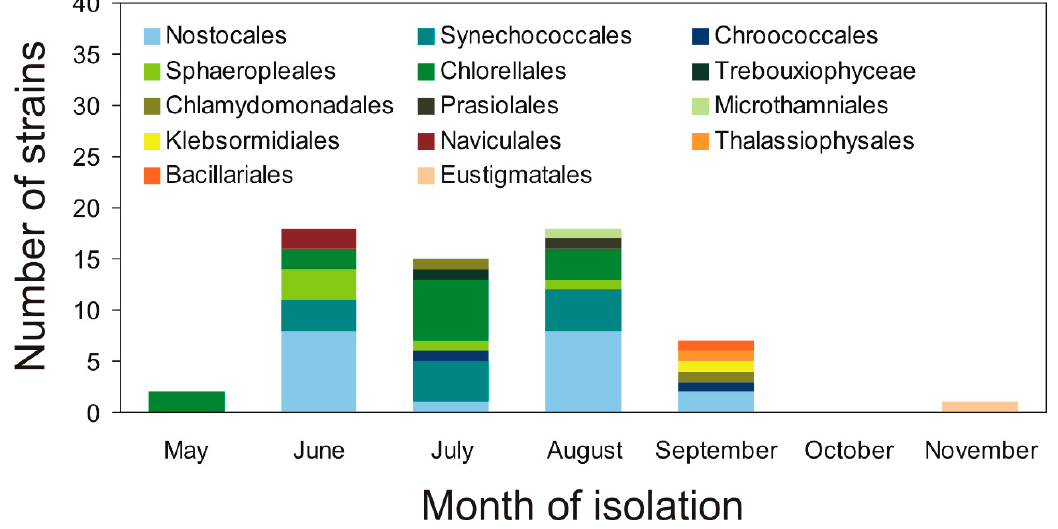
Figure 1. The number of airborne cyanobacteria and microalgae strains belonging to orders isolated in the study period (2018–2020).